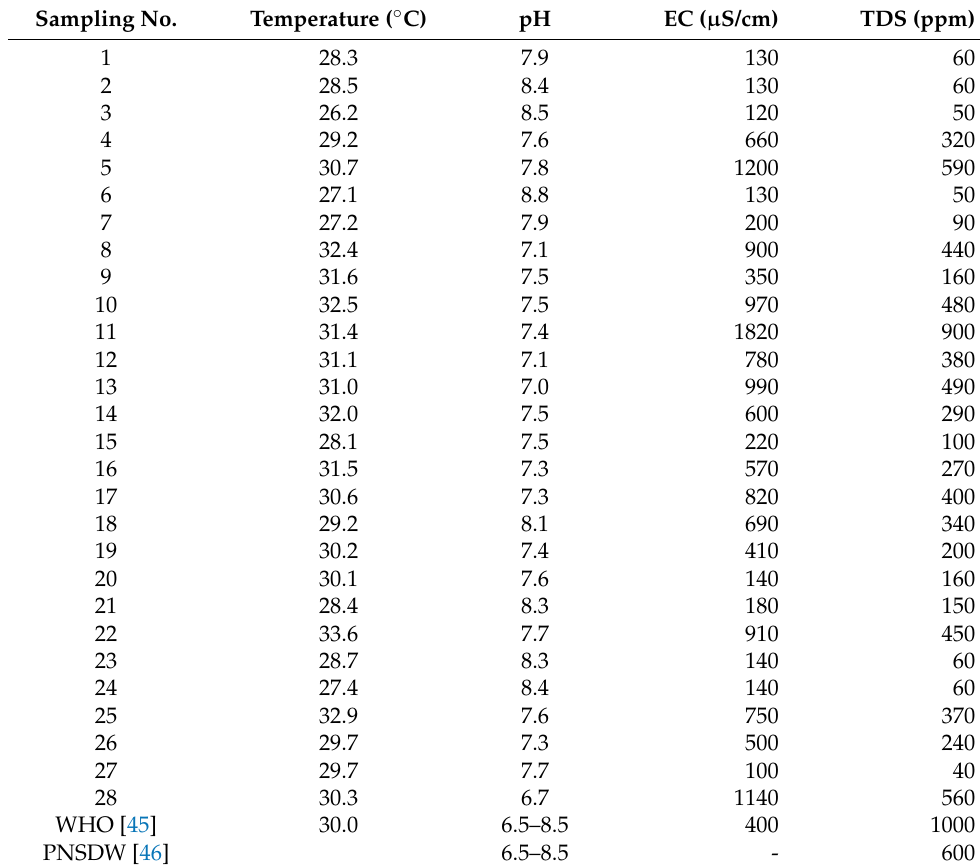
Table 1. The groundwater physical and chemical properties. Sampling